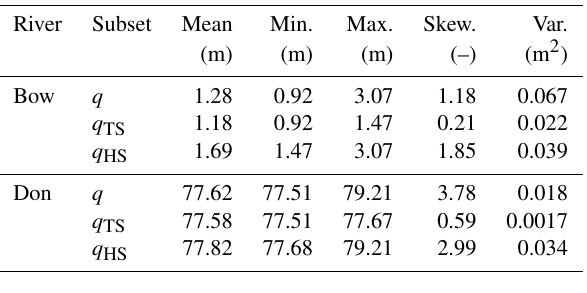
Table 1. Target variable statistics for the Bow and Don River water- sheds.